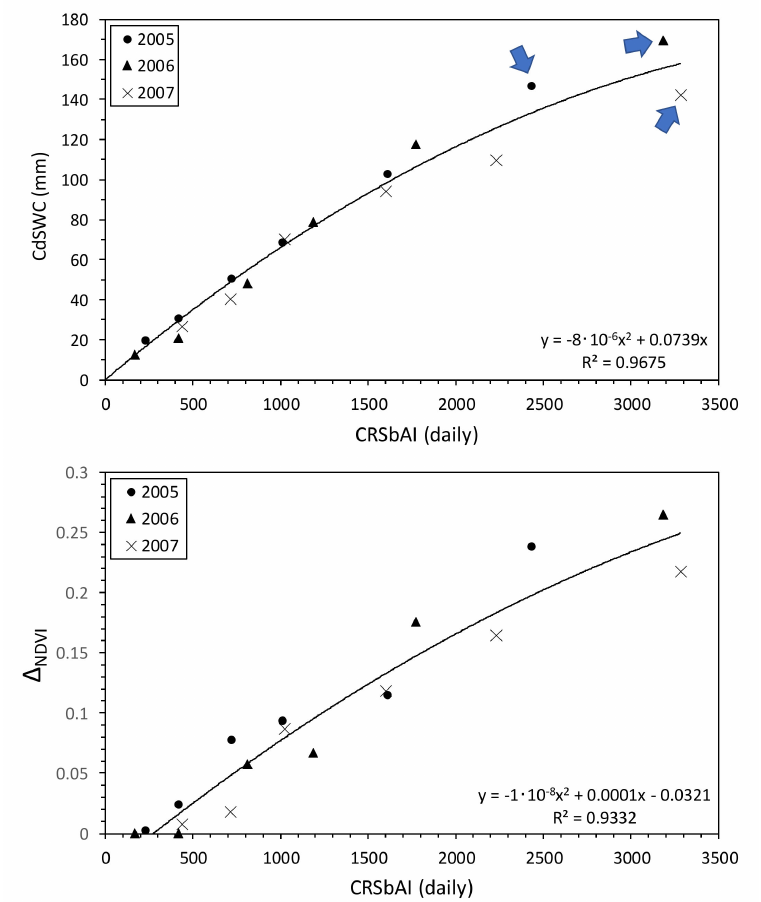
Figure 5. Relationships of CRSbAI (daily) with CdSWC and ∆ NDVI in Shenmu from 2005 to 2007. Blue arrows show the final CdSWC